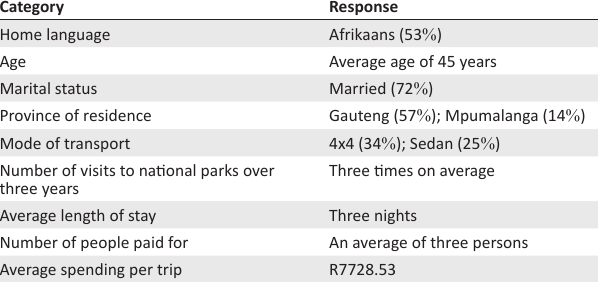
TABLE 1: Profile of Kruger National Park